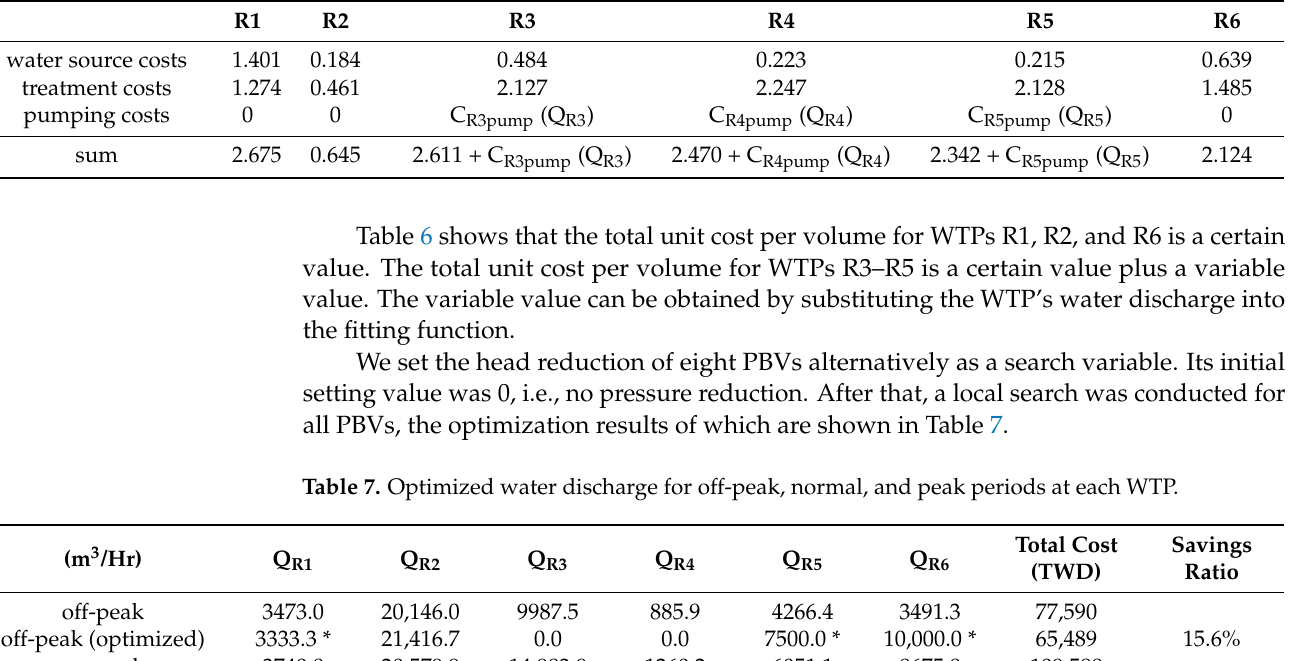
Table 6. Design capacity, head, and unit cost of water discharge for each WTP(TWD/m 3 ). R1 R2 R3 R4 R5